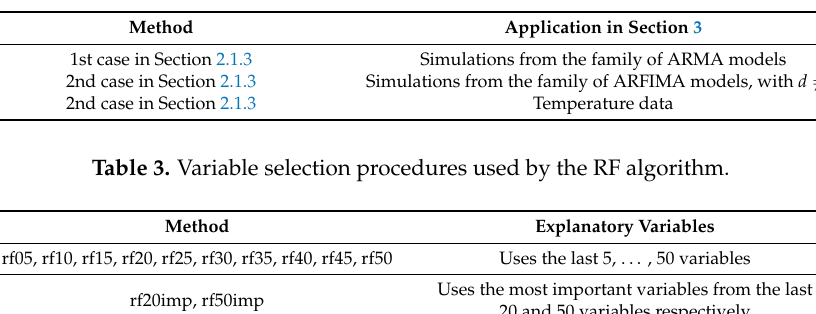
Table 2. Methods presented in Section 2.1.3 for forecasting using ARMA and ARFIMA models and their specific applications in Section 3.